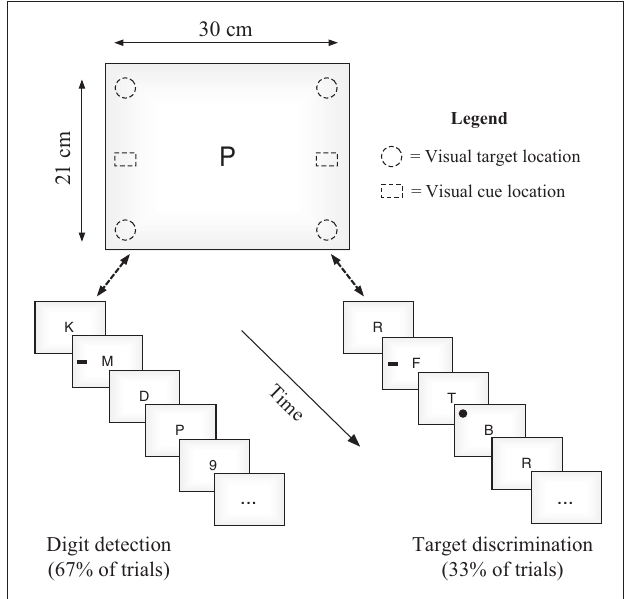
FIGURE 1 | Schematic representation of the task. Both types of trials (digit detection occurring 2/3 of the time, and spatial detection occurring 1/3 of the time) were interleaved and randomized, with cues being presented on every trial, in either the third or sixth position in the stream.